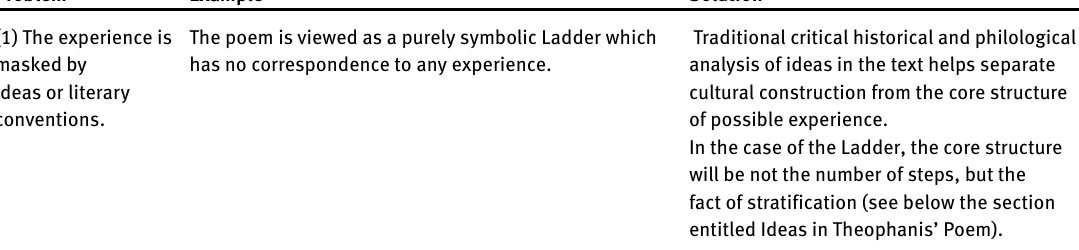
Table 1. Analytic problems in the extraction of experience from textual evidence 24252627